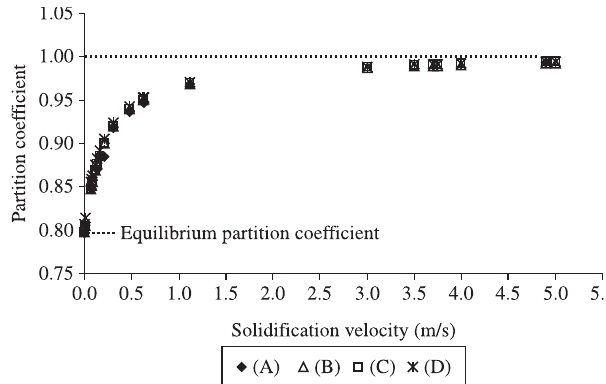
Figure 6. The effect of solidification velocity on Cu partition coefficient: A) Present phase-field calculations; B) best fit of equations 2,4,5; C) best fit of equation 3,4,5 using V = 10 m/s; and D) best fit of equations 1,4,5 using DS V =10 m/s and c0 = 0.05. DS